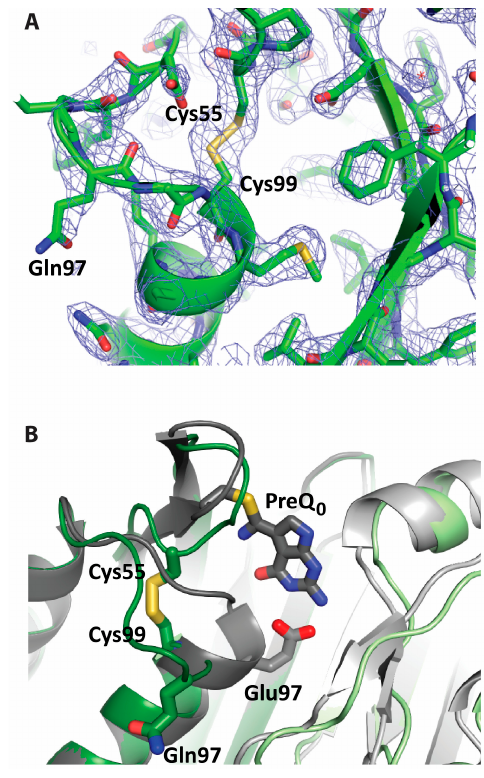
Figure 5. View of the intramolecular disulfide bridge in the active site of the Glu97Gln mutant of B. subtilis QueF. ( A ) 2 Fo - Fc electron density map (2.5 Å, contour 1.2 σ ), superposed on the refined model, in the active site region; ( B ) superposition in the active site region of the crystal structures of the Glu97Gln mutant (green) and the wild-type enzyme thioimide intermediate (grey, PDB ID 4F8B) showing conformational changes associated with disulfide formation. The two interface subunits are shown in two shades of color. Bound preQ 0 in the active site of wild-type QueF and key active site residues are shown in stick diagram and labeled.